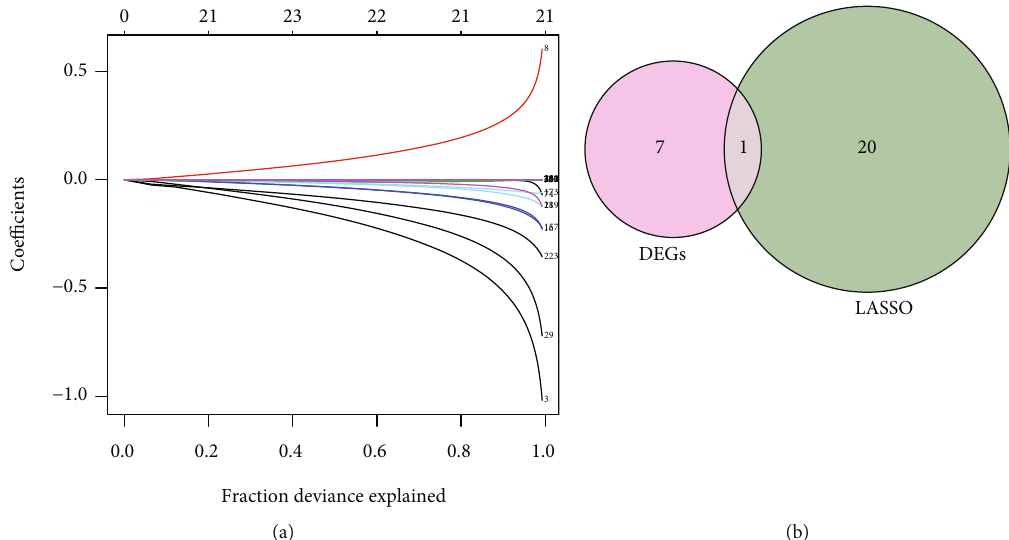
Figure 3: Results of hubgenes screening: (a) the fi tted regression curve in LASSO model; (b) Venn diagram of hubgenes